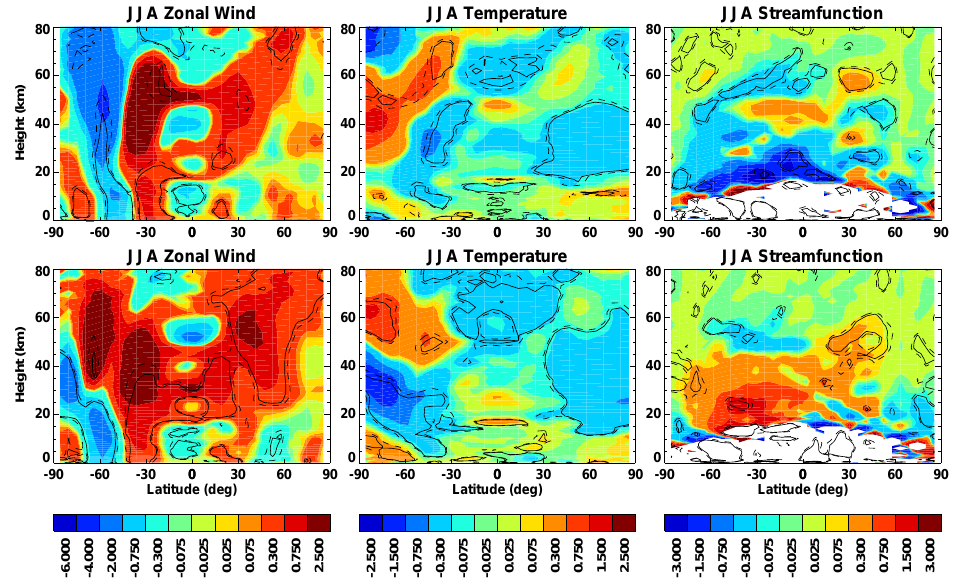
Fig. 12. June–August run mean difference from the ensemble reference run of zonal wind (left, ms − 1 ), temperature (center, K) and mass streamfunction (right, kgm − 1 s − 1 ) for two of the combined EPP ensemble members. Top, weak vortex case. Bottom, strong vortex case.